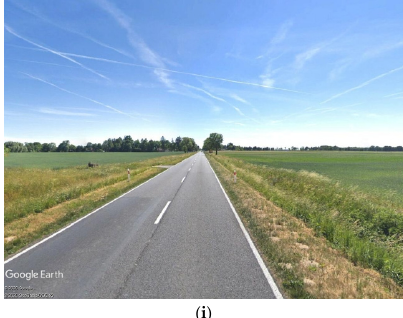
Figure 1. View ahead seen by the driver approaching the village on the respective test sections in the order of reduction of the 85th percentile speed ∆ v 85 : ( a ) No. 1, open rural area, very good visibility of the village skyline and of nearby buildings; ( b ) No. 2, open rural area, view of distant village buildings located along the opposite lane of travel; ( c ) No. 3, open rural area, poor visibility of the village skyline and of nearby buildings; ( d ) No. 4, forest terrain, limited visibility of dispersed buildings; ( e ) No. 5, rural area, along a row of trees, poor visibility of the village skyline; ( f ) No. 6, forest area, village skyline and buildings not visible; ( g ) No. 7, open rural area, good visibility of the village skyline in the distance; ( h ) No. 8, open rural area, village skyline not visible; ( i ) No. 9, open rural area, poorly visible village skyline (source of images in Figures 1b,h,i: Google Earth–Street View [52]). The analysis of the main features of the transition zones under study showed that on the basis of the general traffic management scheme trends, as described in [1,2,5,19,43,53], two configurations of positioning vertical signs can be identified: basic, classic (Figure 2) and the one used in the test sections (Figure 3). The first traffic management scheme, presented in Figure 3 relates to the transition zones where the greatest speed reductions were noted, with the chicanes placed between the traffic signs E-17 and D-42 (Figure 3a). Smaller speed reductions were recorded where a central island horizontally deflecting one lane was located before the traffic signs No. E-17 ‘city’ and No. D-42 ‘built- up area’ (Figure 3b).